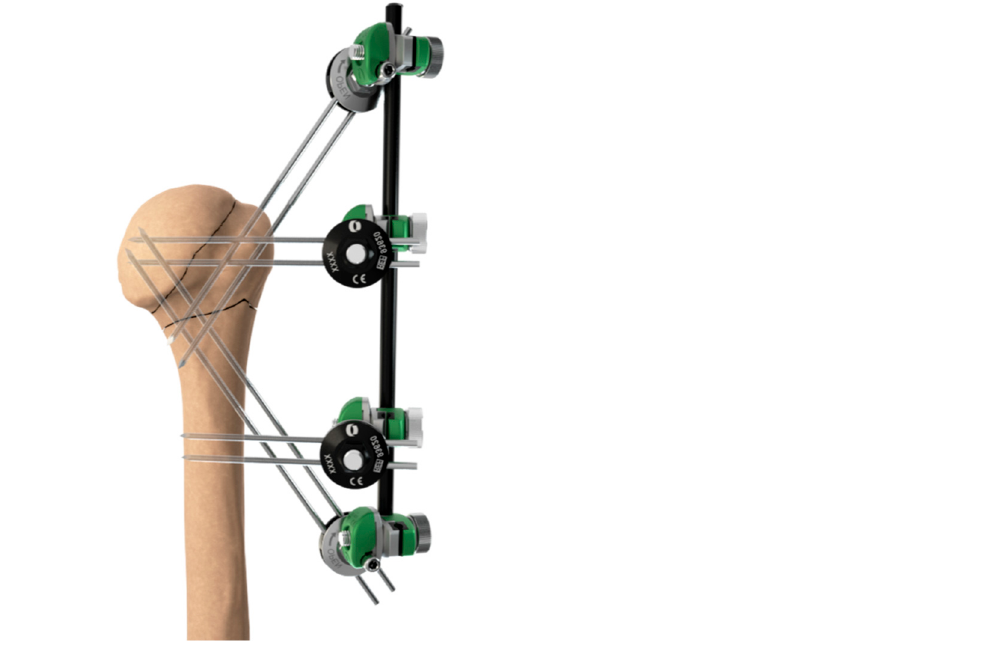
Figure 3. Left three-part posterior fracture-dislocation of the humeral head with composite tuberosity shield fragment treated with a biomechanically validated configuration of blocked threaded